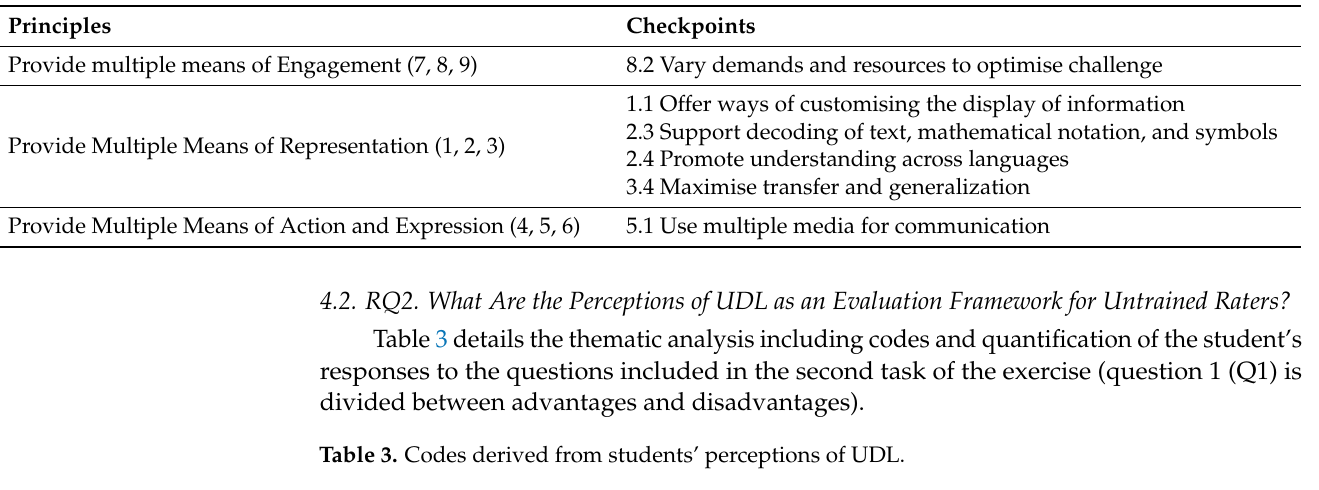
Table 2. Checkpoints with a slight agreement.